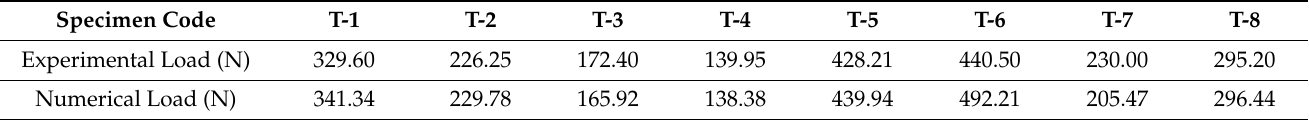
Table 4. Comparison between experimental and numerical loads obtained in